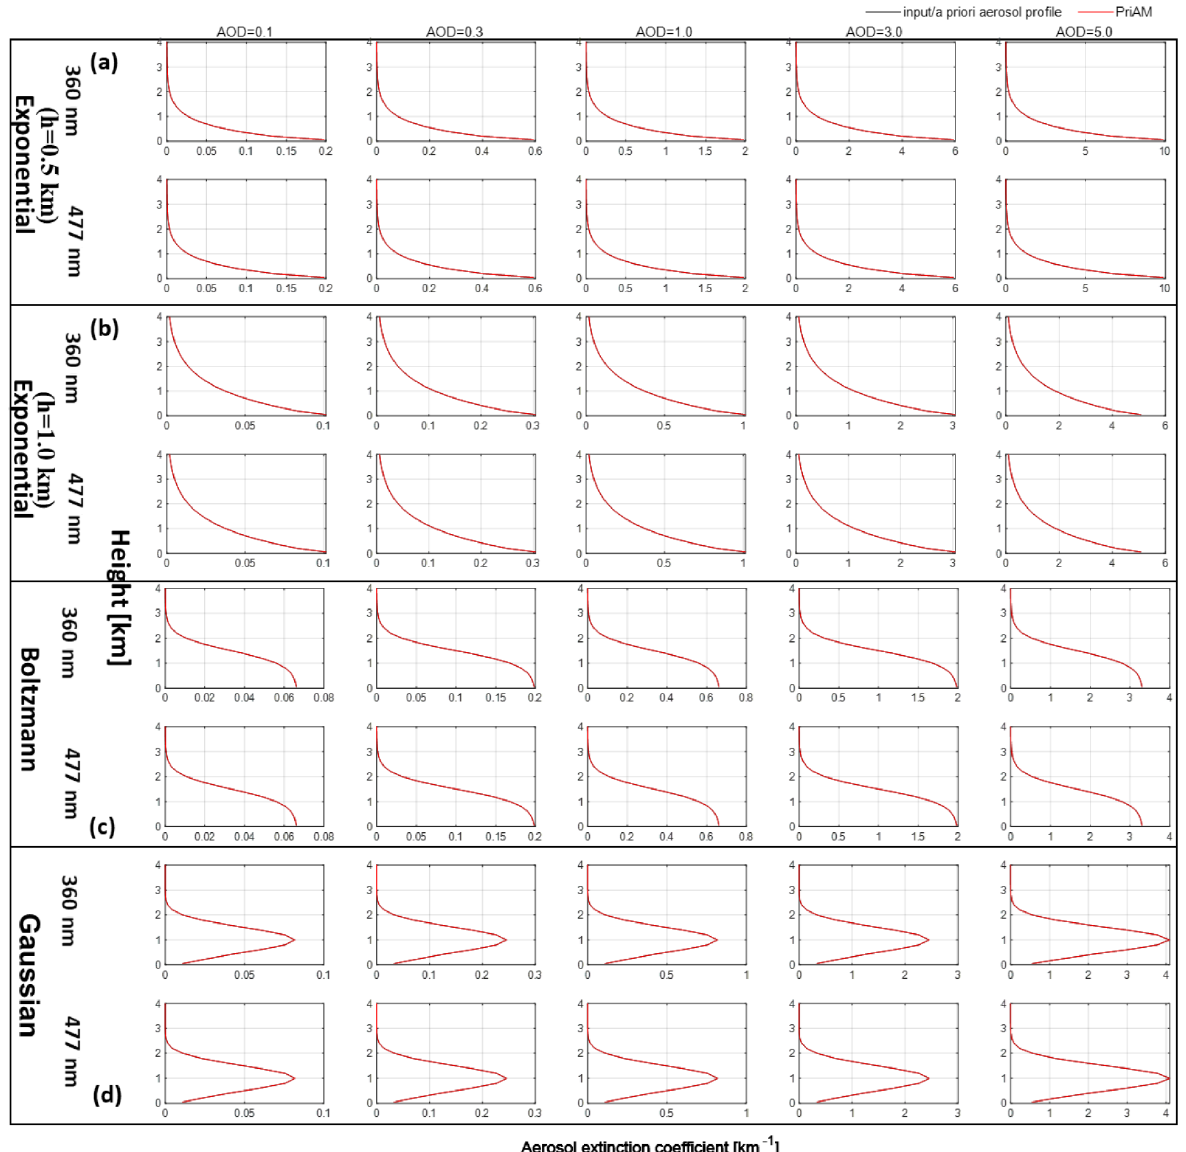
Figure 5. Comparison of the input aerosol profiles and the PriAM inversion results if the exact a priori profiles are used as input profiles. The first line in every panel denotes the results for 360nm, and the second line denotes the results for 477nm. The black and red curves indicate the input (the same as the a priori profile) and retrieved aerosol profiles by PriAM,